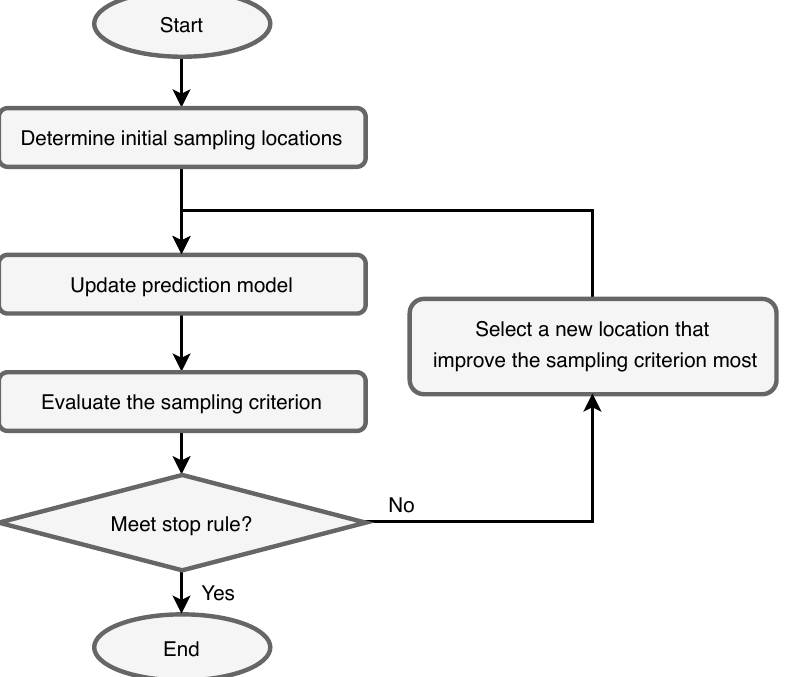
Figure 7. The procedure of adaptive sampling